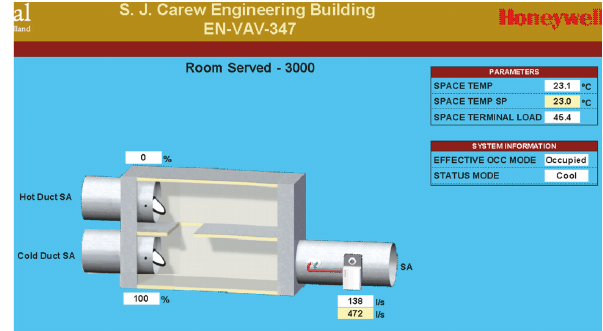
Figure 2: AHU 1 for S.J. Carew building.